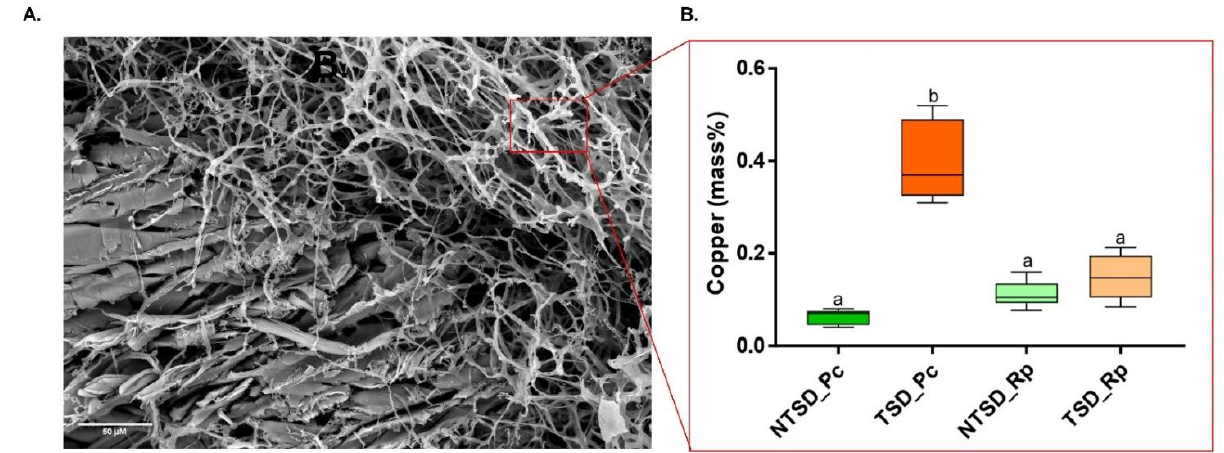
Figure 4. SEM-EDS-based copper quantification in fungal hyphae of P. chrysosporium and R. placenta after 10 days in the microcosm with TSD or NTSD. ( A ) SEM image of P. chrysosporium hyphae. Zones only focusing on mycelium and avoiding detecting copper in the wood substrate were selected for analysis. ( B ) Copper amount in fungal hyphae (mean ± s.e., n = 9, one-way ANOVA and Tukey’s post hoc test ( p -value ≤ 0.05), different letters to show statistically significant differences).